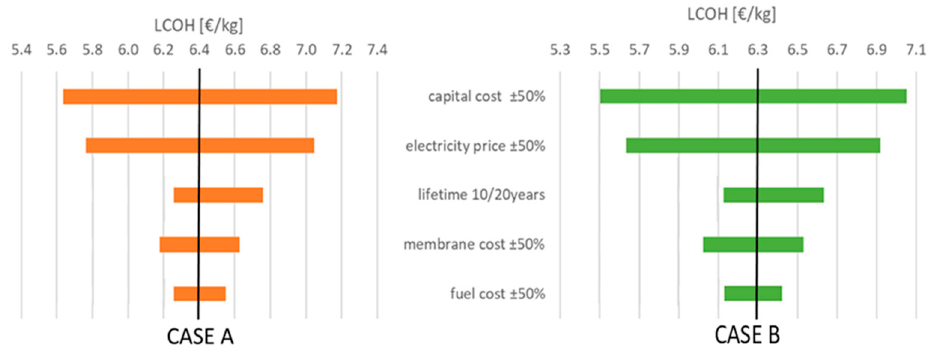
Figure 10. Sensitivity analysis on main economic assumptions for Case A (left) and Case B (right). LCOH cost calculated assuming H 2 at 700 bar.